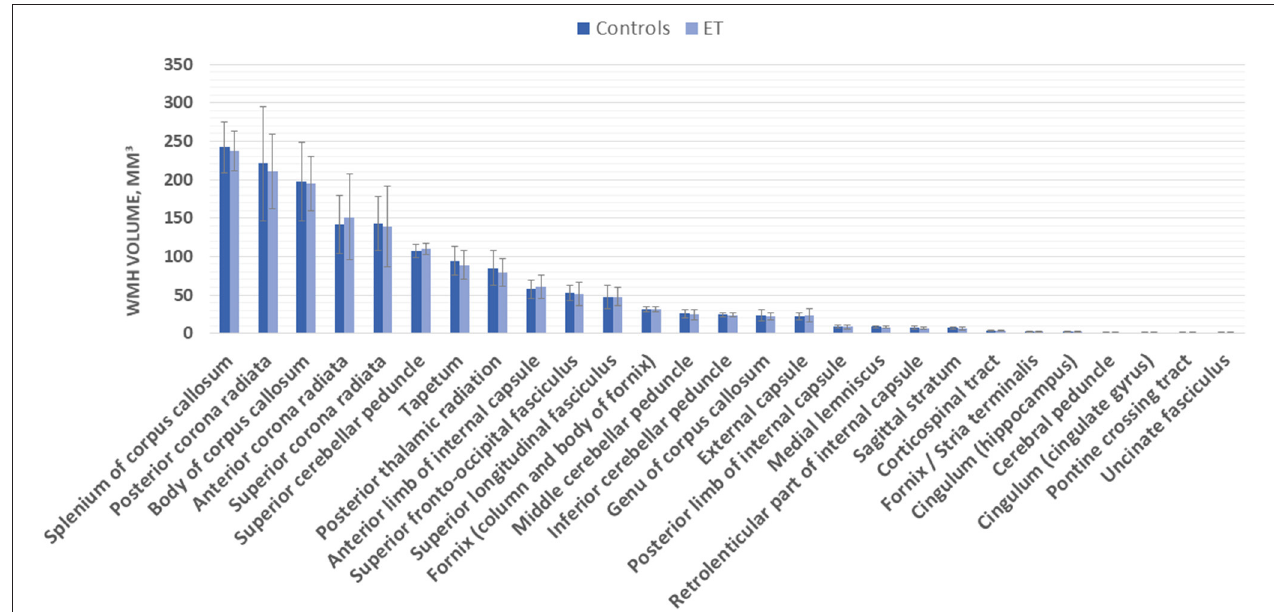
FIGURE 2 | Region of interest (ROI)-specific white matter hyperintensity (WMH) volume (in mm 3 ) in essential tremor (ET) patients and controls.